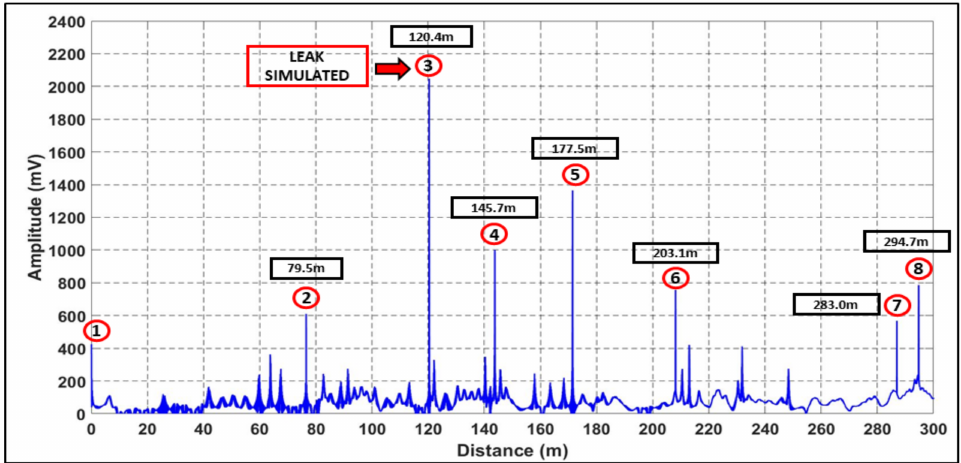
Figure 21. Hilbert Transform (HT) analysis IMF series 6 for 5 mm leak induced on fire hydrant